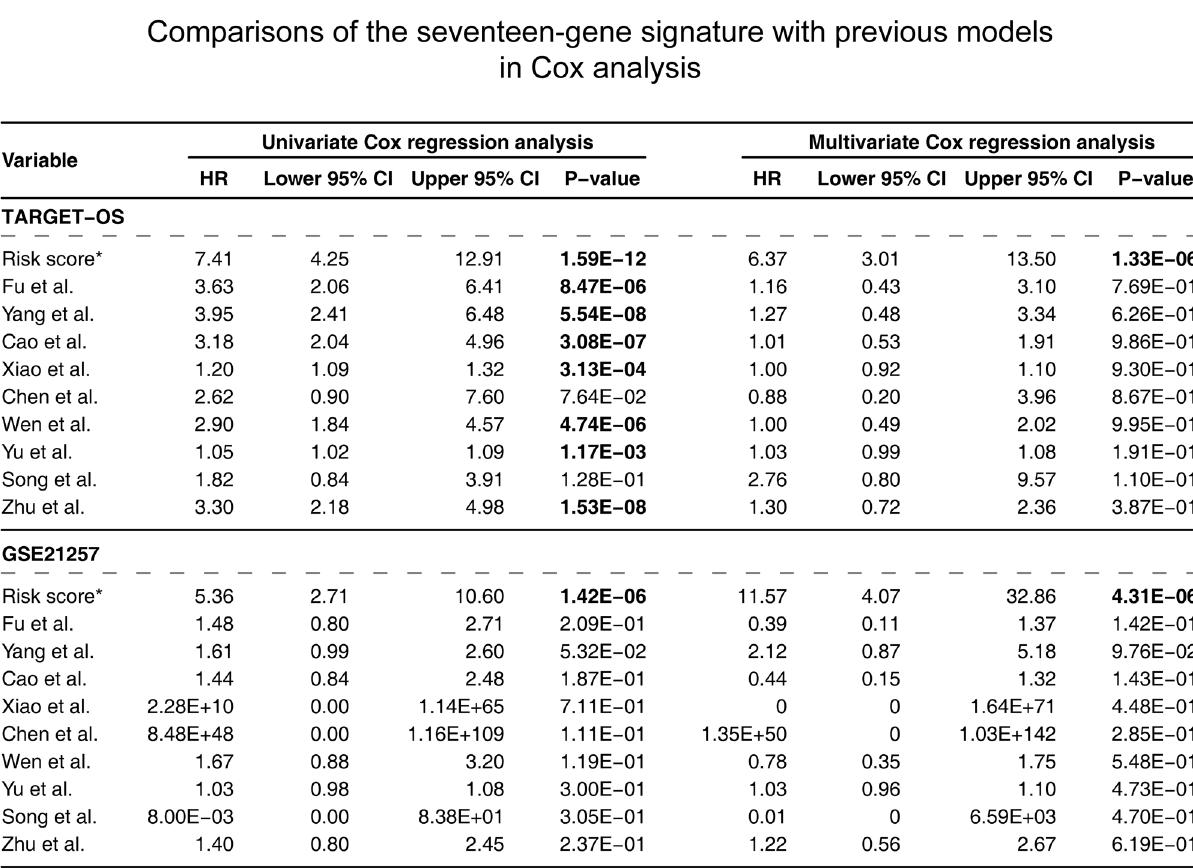
Figure 8. Comparisons between the seventeen-gene signature and previous studies conducted in the training and validation cohorts using Cox models. HR hazard ratio, CI confidence interval. *The seventeen-gene signature that identified in this study; the bold p value indicates that < 0.05, which considers